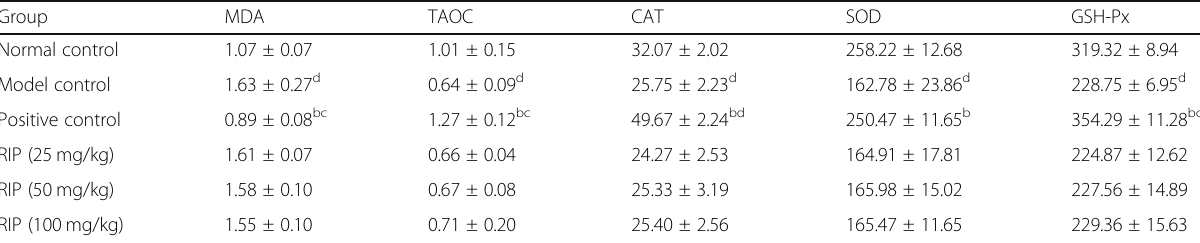
Table 7 Effects of different treatments on the activities of CAT (U/mg protein), SOD (U/mg protein), GSH-Px (U/mg protein) and levels of MDA (nmol/mg protein) and TAOC (U/mg protein) in the brains of aging mice Group MDA TAOC CAT SOD